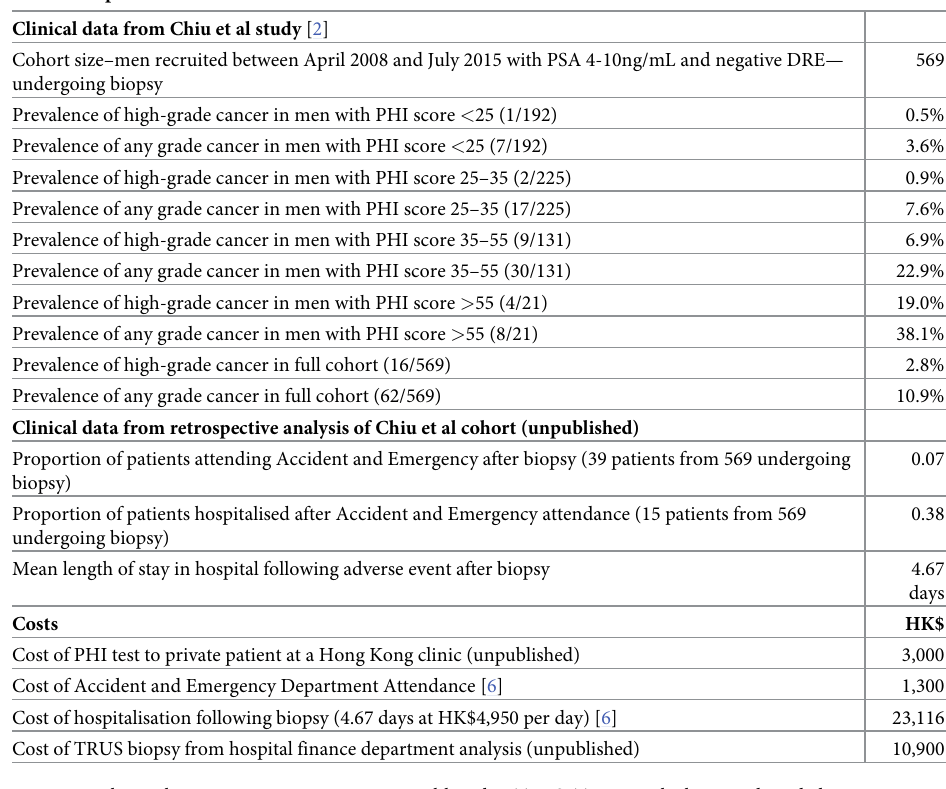
569 0.07 0.38 days 23,116 10,900